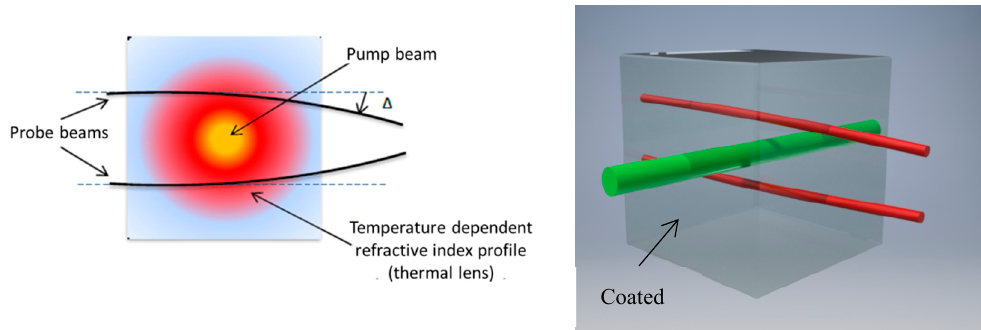
Figure 3. General scheme for the laser-induced deflection (LID) photothermal technique ( left ) and the measurement concept for rectangular substrate geometries ( right ).